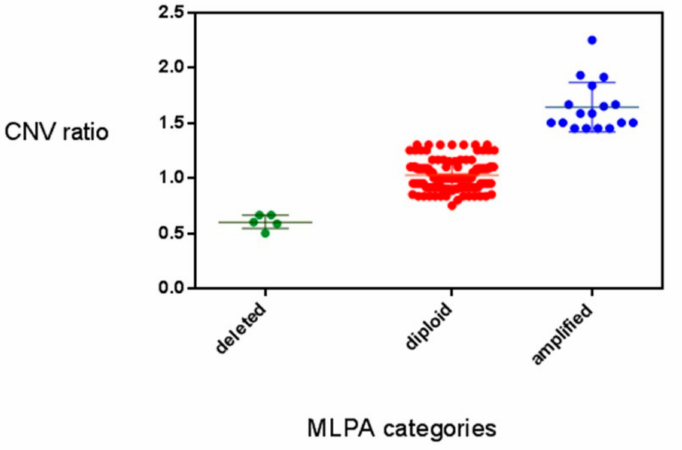
Figure 2. Comparison between MLPA and Copy Number Variation (CNV) values showing 3 different CNV